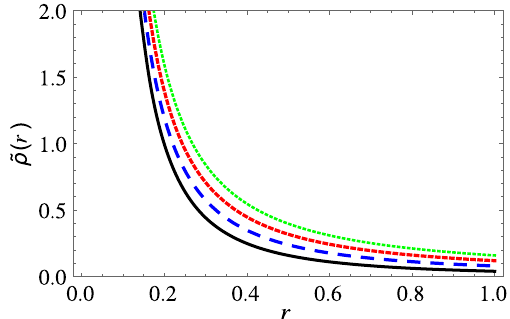
Fig. 3 Scale-dependent density for (cid:13) = 0 . 00 (black solid line), (cid:13) = 1 . 00 (dashed blue line), (cid:13) = 2 . 00 (short dashed red line), (cid:13) = 3 . 00 (dotted green line). The other values have been taken as unity. See text for details